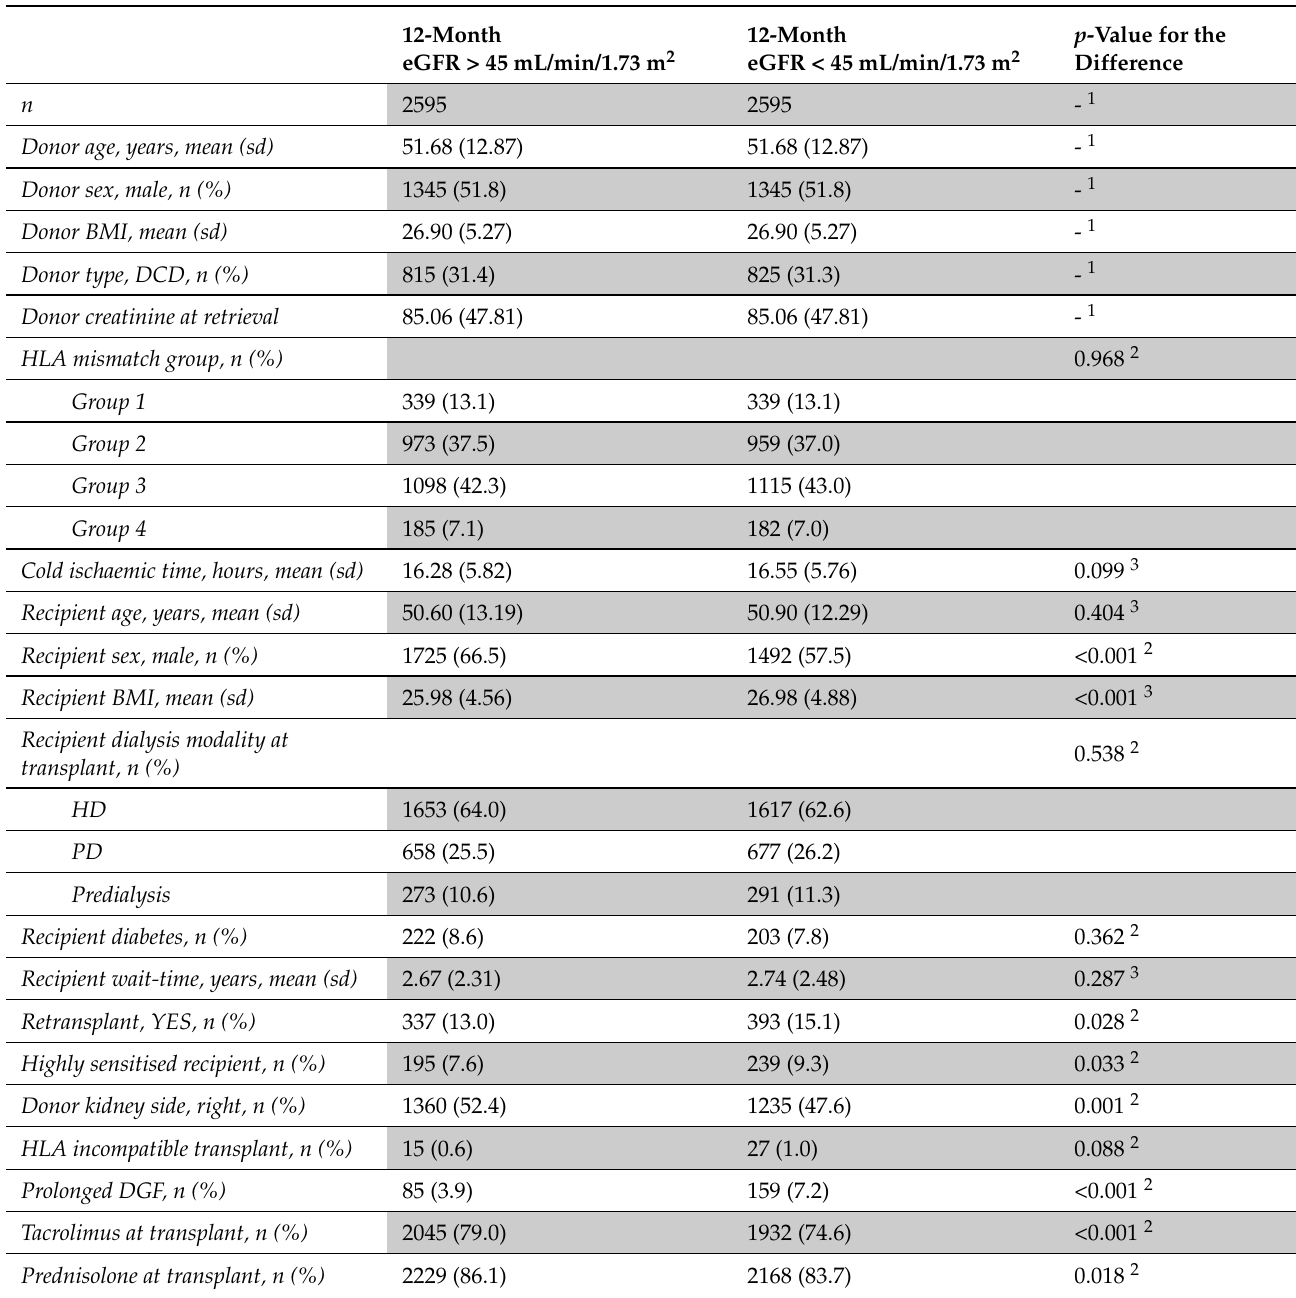
Table 3. Univariate analysis—Pairs discordant for good 12-month function (cut point 45